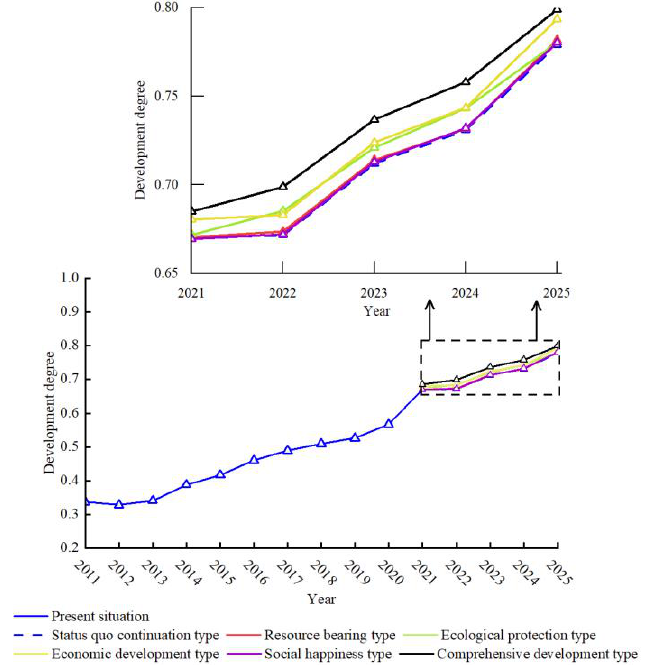
Figure 6. Governance result graph. Chart of regulation results under each scheme.